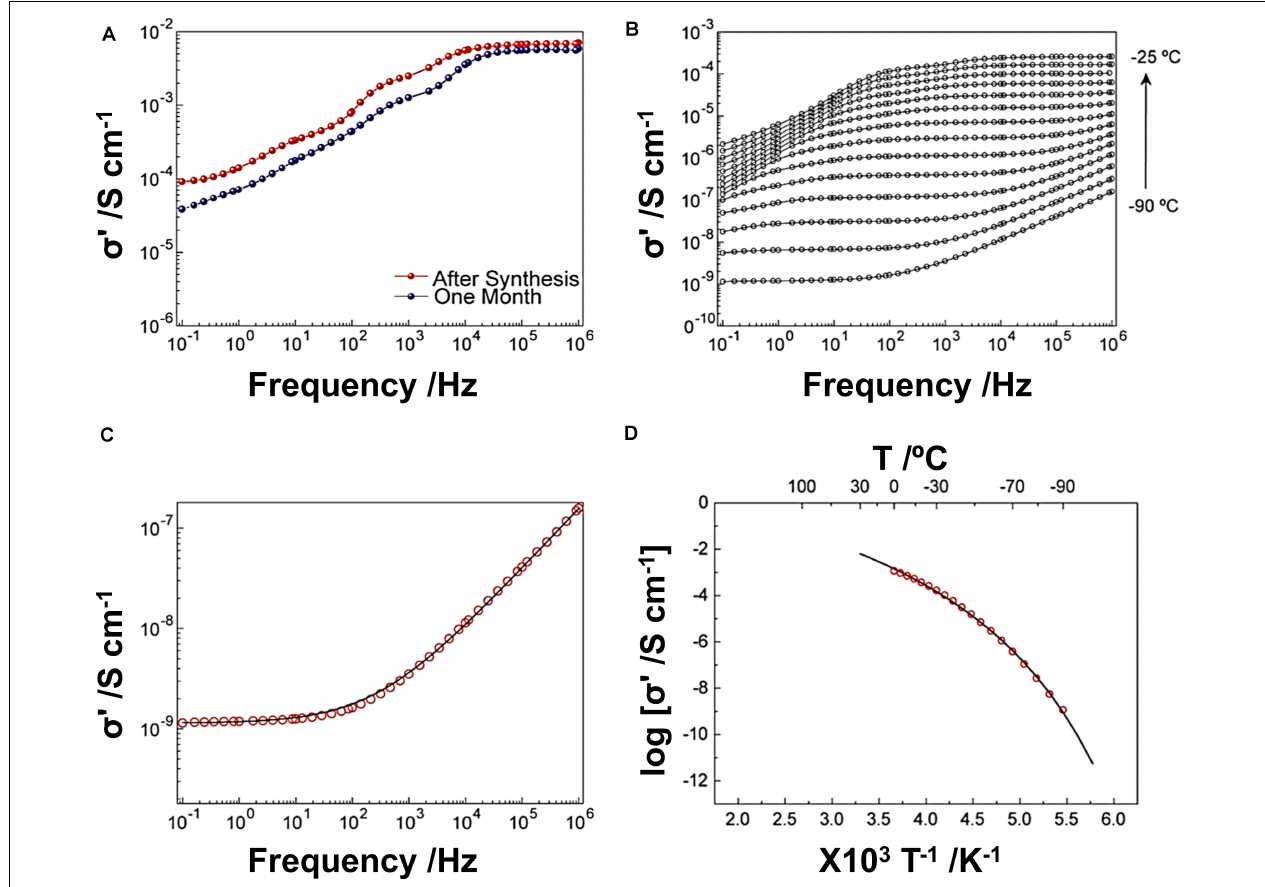
FIGURE 4 | (A) Conductivity at room temperature of CSE after synthesis and after one month, (B) conductivity of CSE from − 90 ◦ C to − 25 ◦ C, with a step of 5 ◦ C, (C) Jonscher fit for − 90 ◦ C, and (D) Thermal evolution of conductivity of